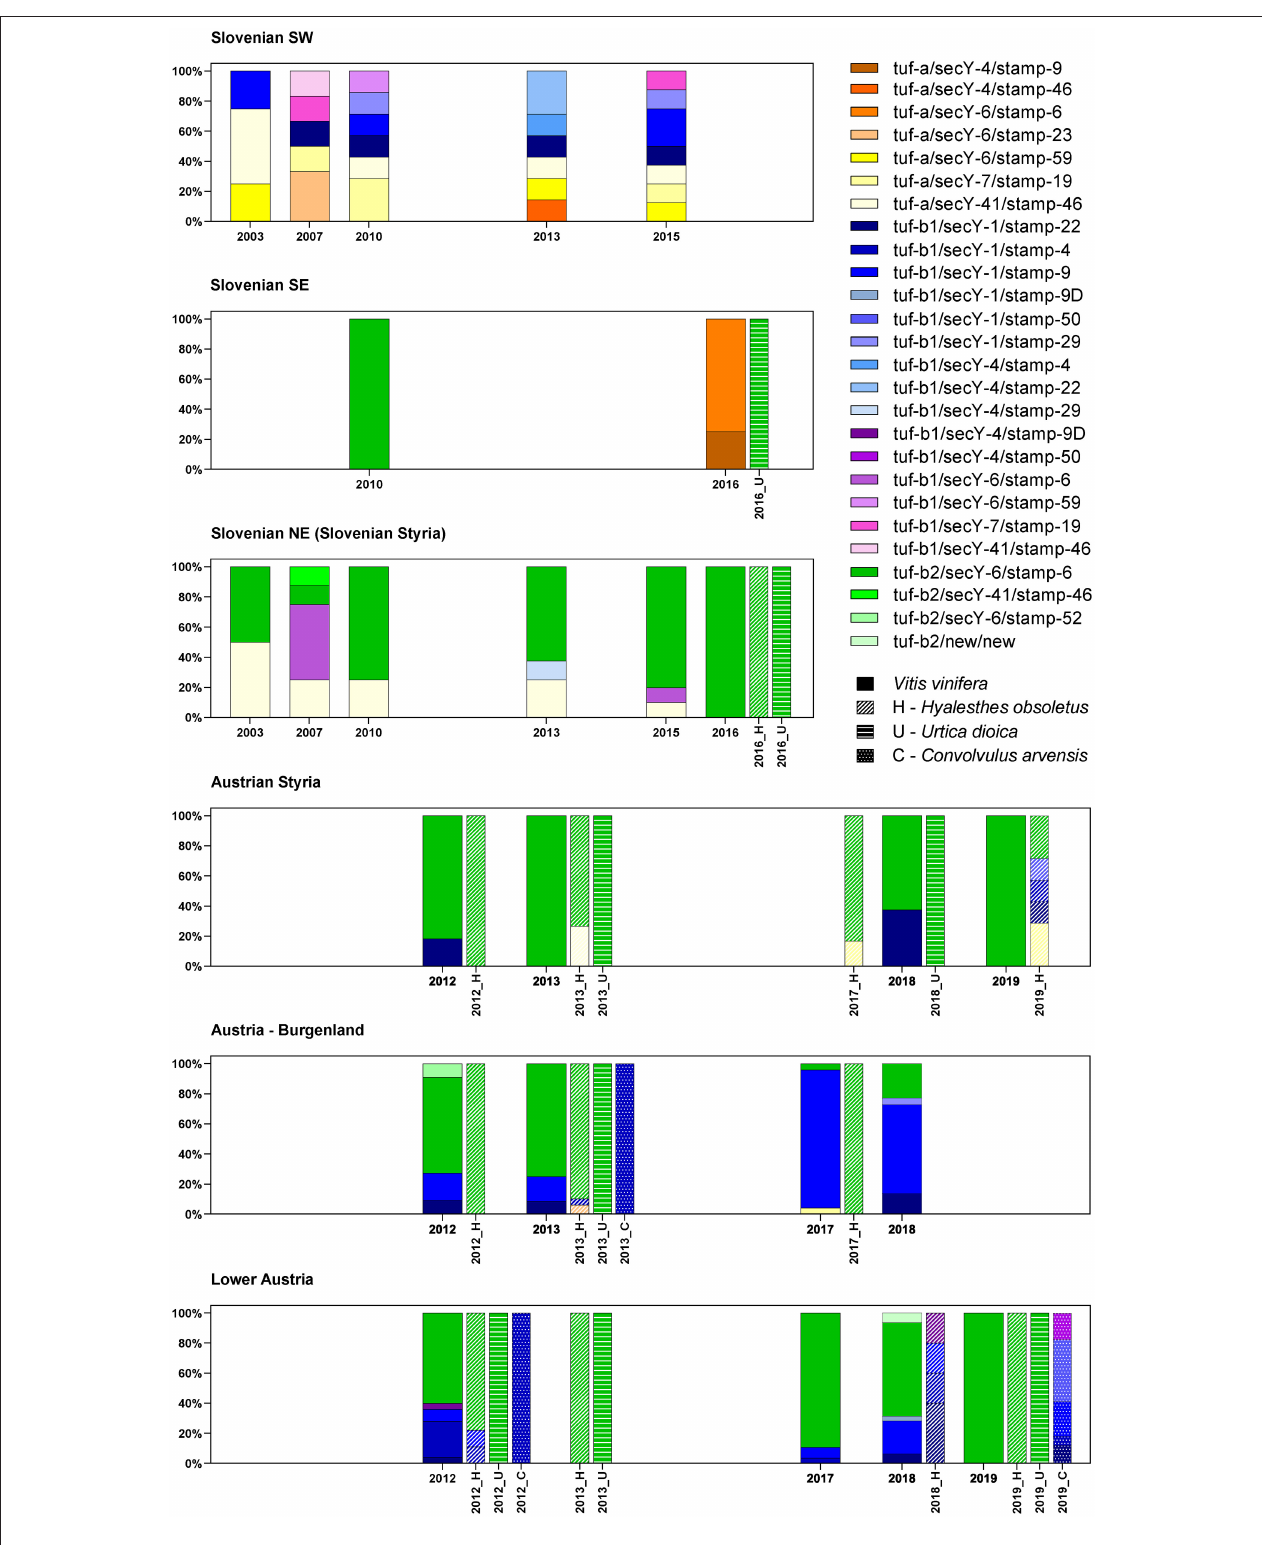
FIGURE 2 | Spatial and temporal diversity of the haplotypes associated with “ Ca . P. solani” in Slovenia and Austria.